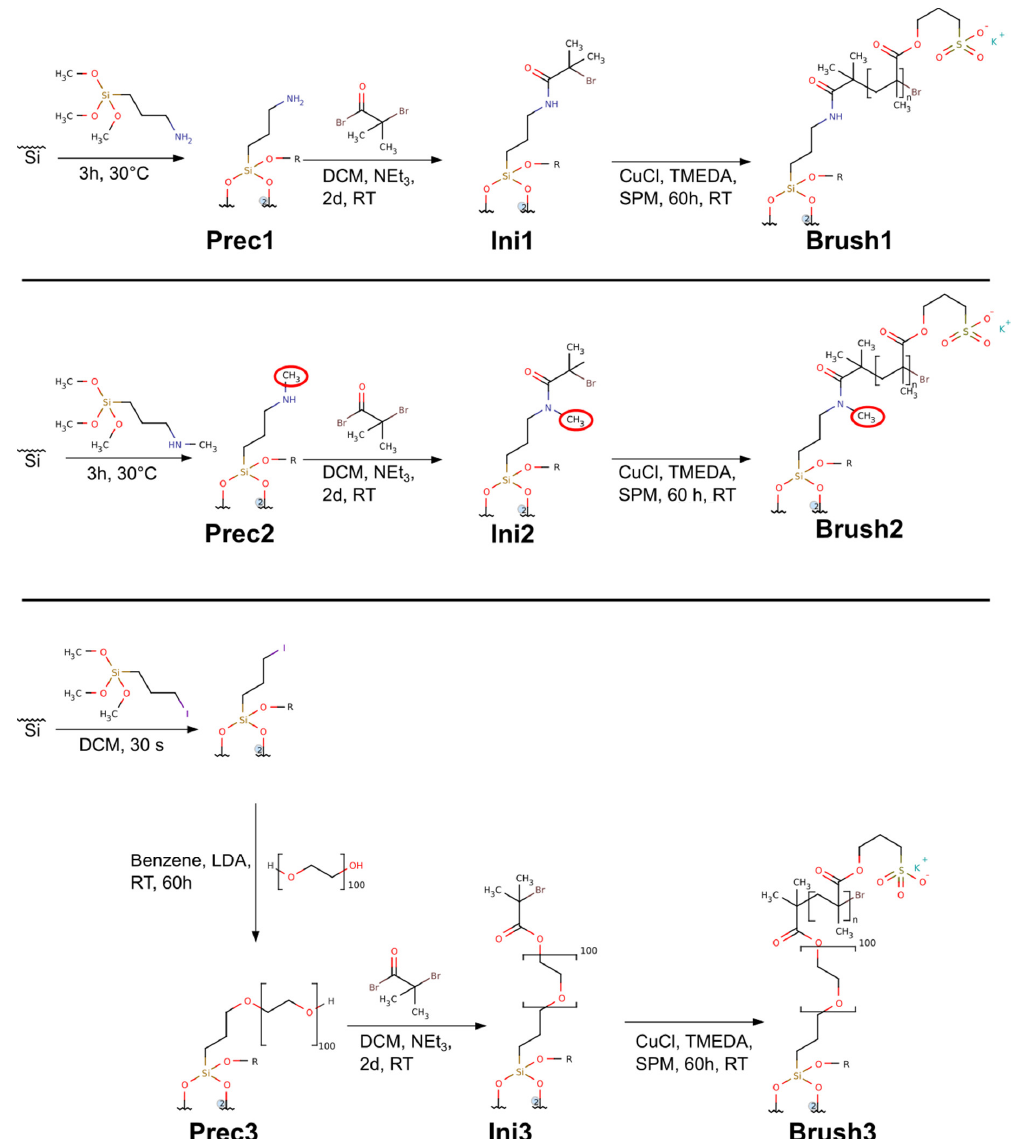
Figure 1. Synthetic route towards the brushes used in this study.